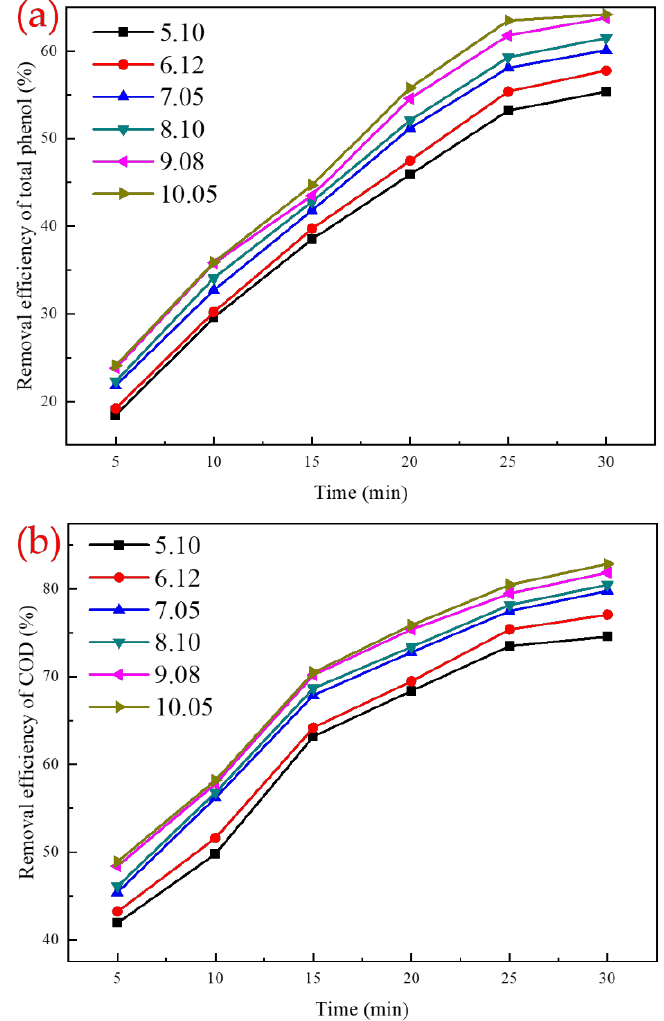
Figure 9. Effects of ozone pH on removal efficiency of ( a ) total phenol and ( b ) COD.